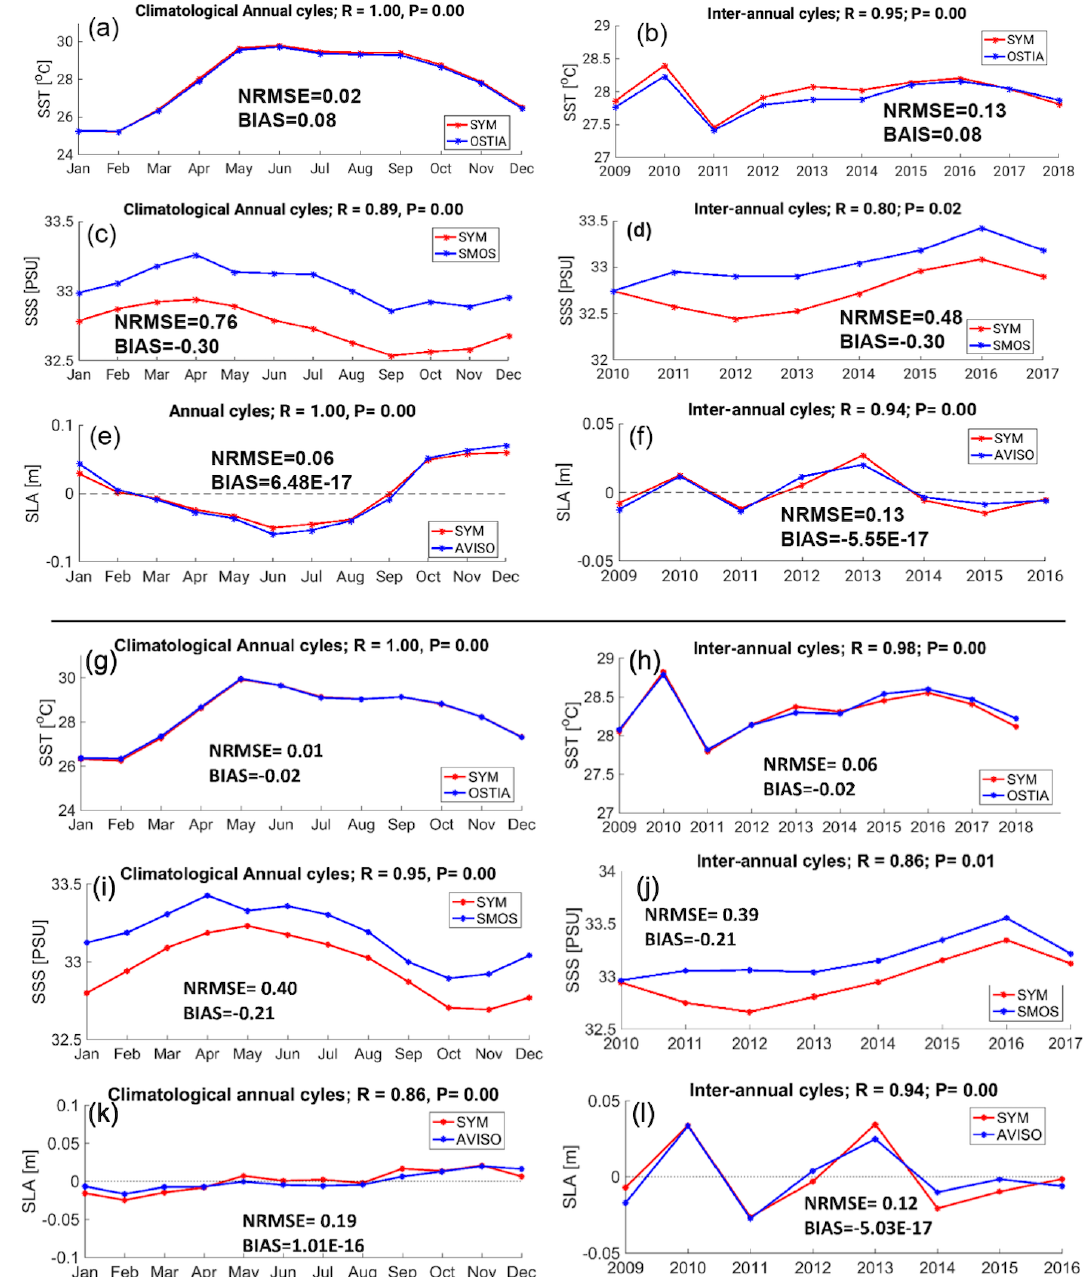
Figure 7. Climatological monthly time series (left) and interannual yearly time series (right) of simulated (red) and observed (blue) SST ( ◦ C), SSS, and SLA (meter) averaged over (a–f) the VNC domain and over (g–l) the SVU area (7–16 ◦ N, 104–116 ◦ E). Correlation (correlation coefficient R and p value P ), NRMSE, and bias of simulated vs. observed values are